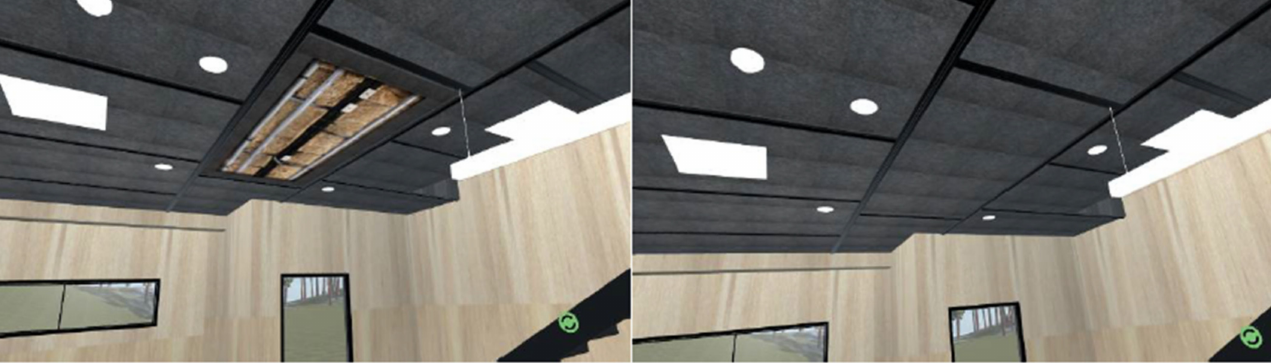
Figure 10. Acoustic felt ceiling panels reveal insulation and allow access to mechanical and electrical plant services throughout the multiple lifecycles of the